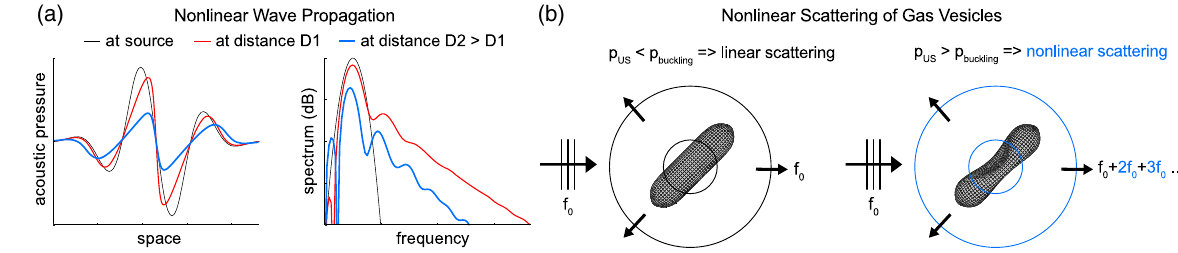
FIG. 1. Sketch of the two nonlinear phenomena that take place while imaging a biological medium containing acoustic biomolecules. (a) Propagation history of a single plane wave: Nonlinear frequency components accumulate with depth as the wave propagates through tissue before being attenuated. This phenomenon, amplified during the near-collinear interaction of two wavefronts, leads to nonlinear propagation artifacts distal to GV inclusions. (b) Nonlinear scattering behavior of GVs insonified above their buckling pressure, enabling their detection with an AM